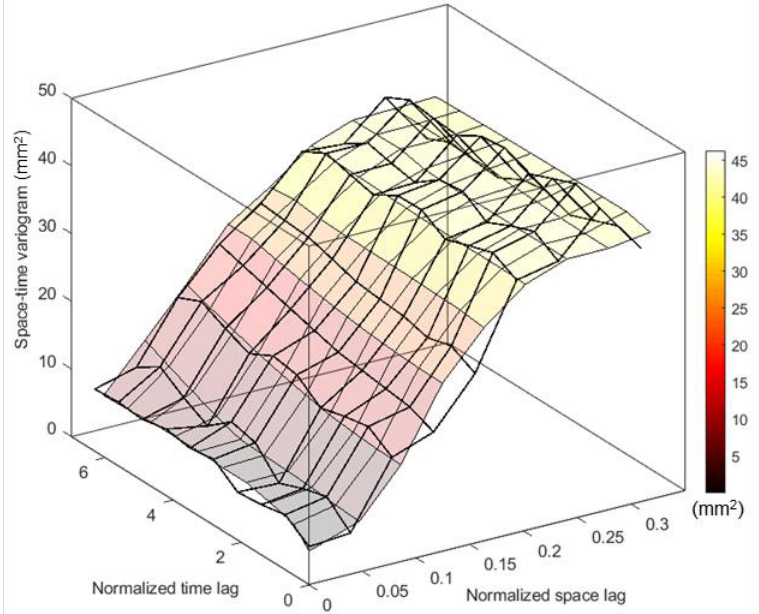
Figure 5. Spatiotemporal variogram fit of the theoretical sum-metric model (colored surface) to the experimental (black line grid).